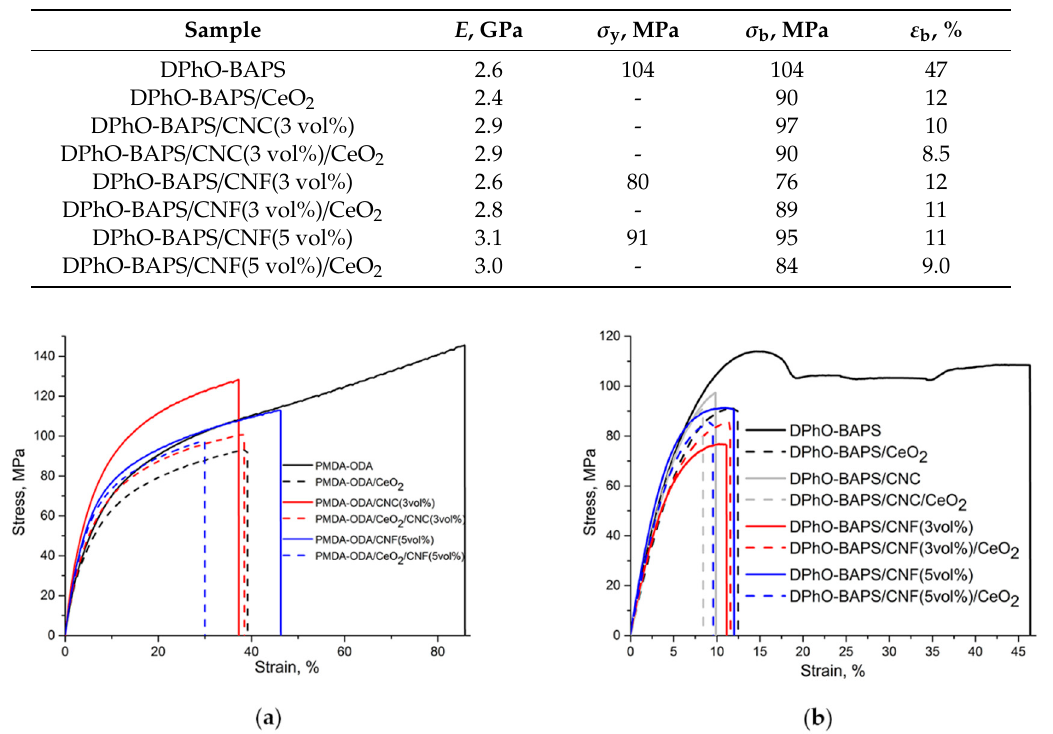
30 Table 5. Mechanical properties of the DPhO-BAPS-based compositions. Sample